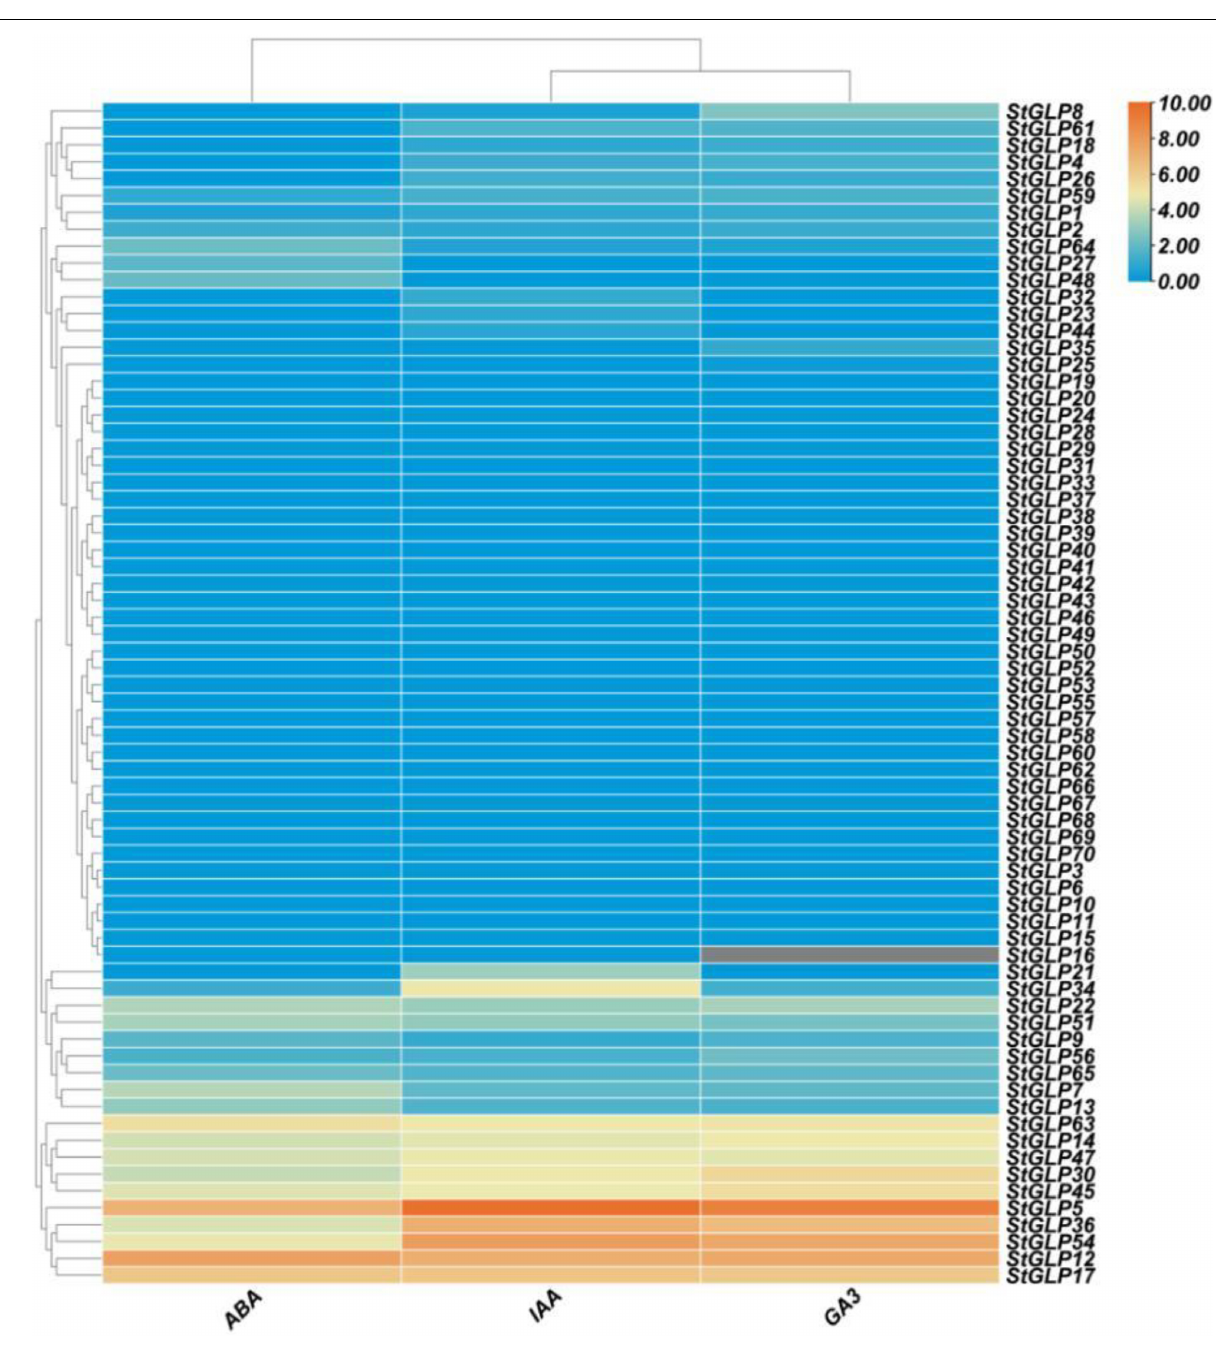
FIGURE 10 | Expression profiling of StGLP genes in response to ABA, IAA, and GA3. The orange and blue colors display high- to low-expression levels. The expression heat map was created by taking log10 of fragments per kilobase million